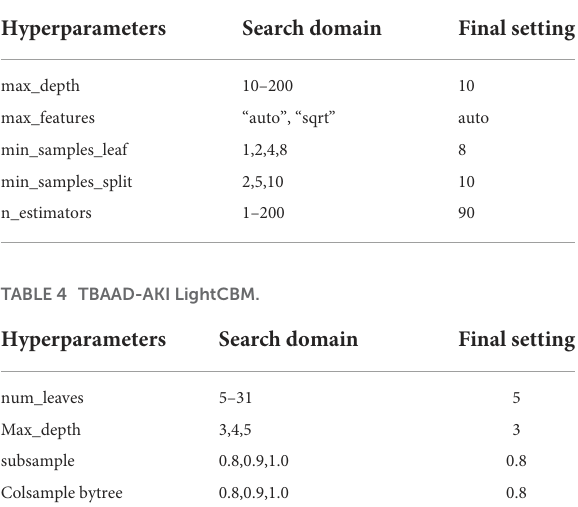
TABLE 3 TAAAD-AKI random forest.